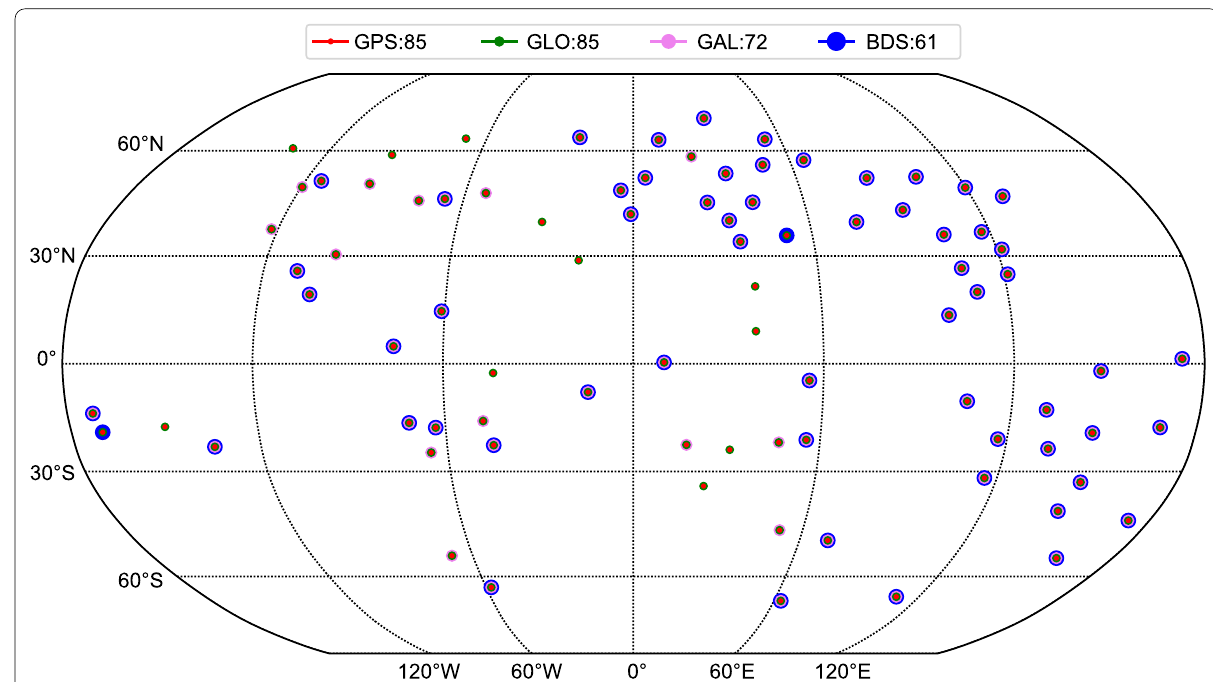
Fig. 3 Distribution of stations for the multi-GNSS real-time clock estimation. All 85 stations can track both GPS and GLONASS signals, among which 72 and 61 stations can track Galileo and BDS-2, respectively